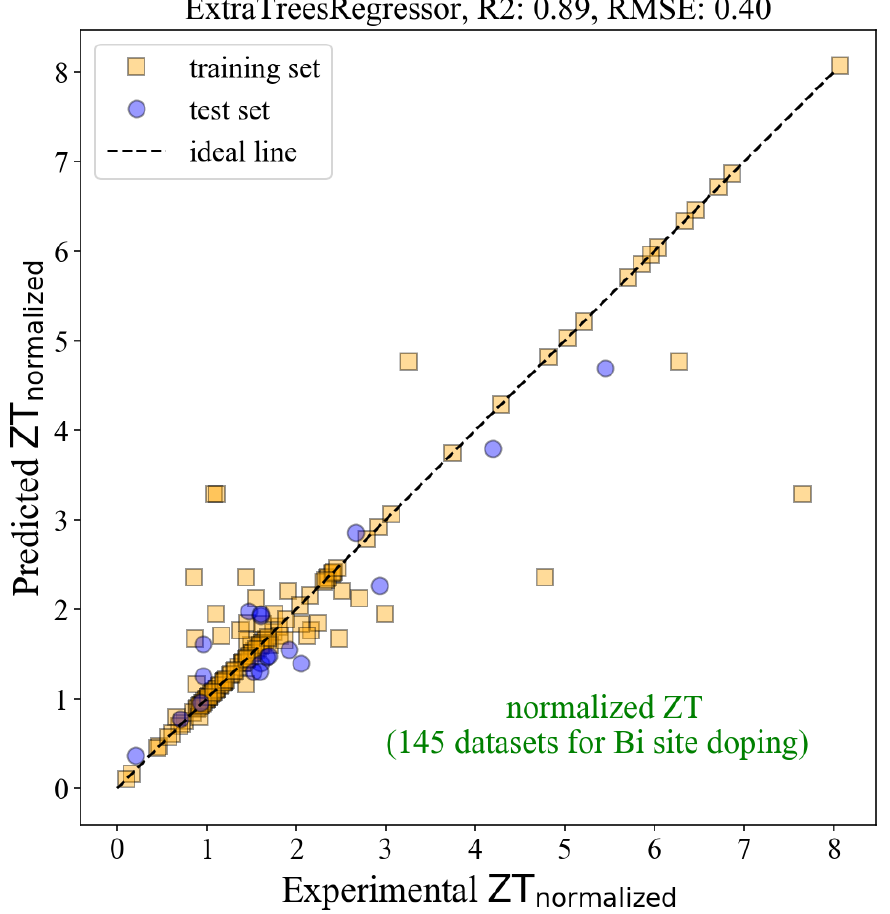
Figure 4. The plot of the Predicted ZT normalized versus the Experimental ZT normalized from the ML model using ET regressor. The total dataset of 145 datasets was used, resulting in the R 2 of 0.89 and the RMSE of 0.40.